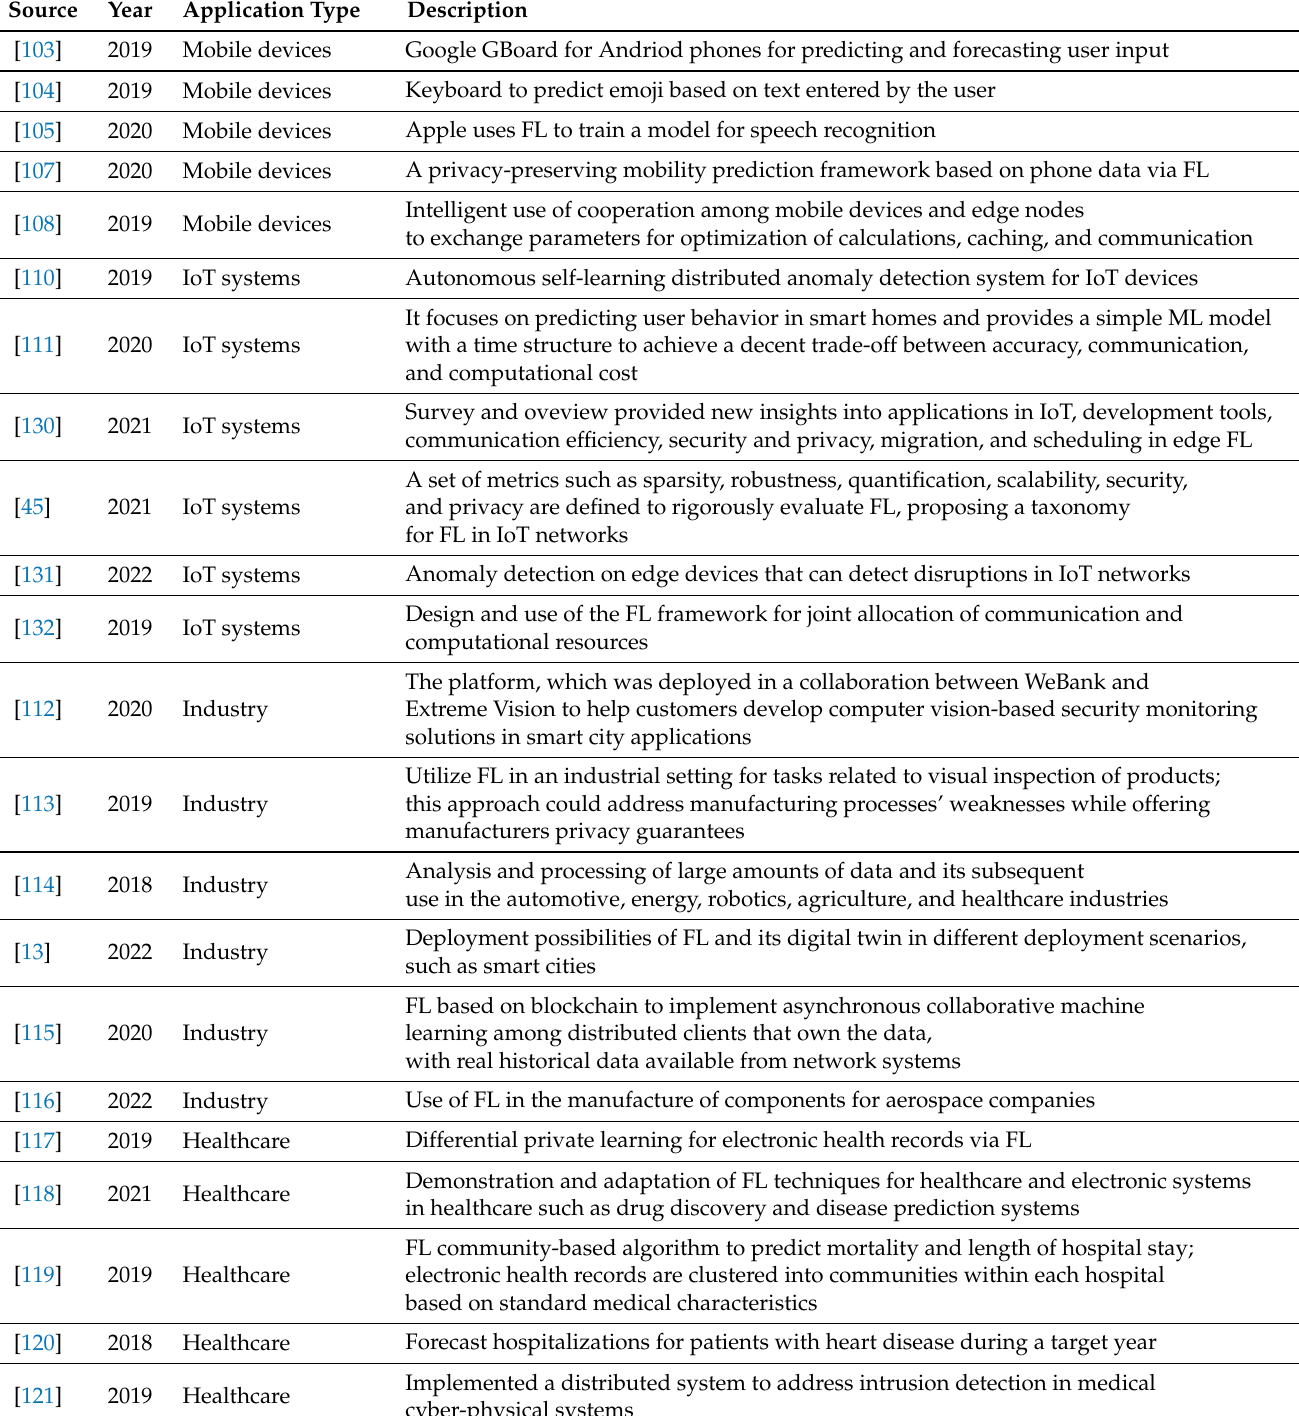
Table 3. Overview of federated learning